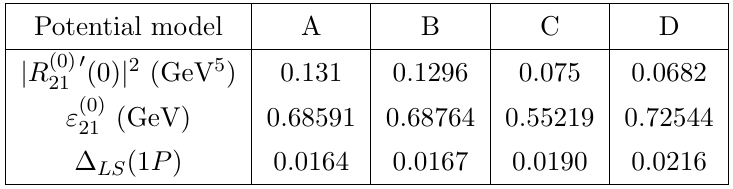
(0) j 2 , the binding energy, " (0) , and the spin-dependent 21 21